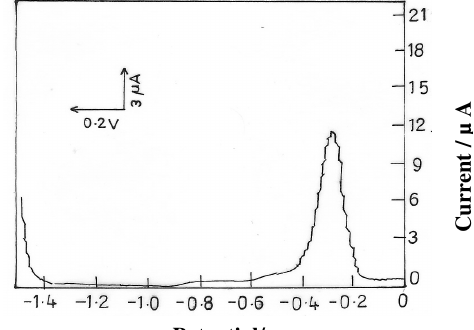
Figure 2. Typical D.C. polarogram of zileuton at pH 4.0, Concentration = 0.5 mM, Drop time = 2 sec.